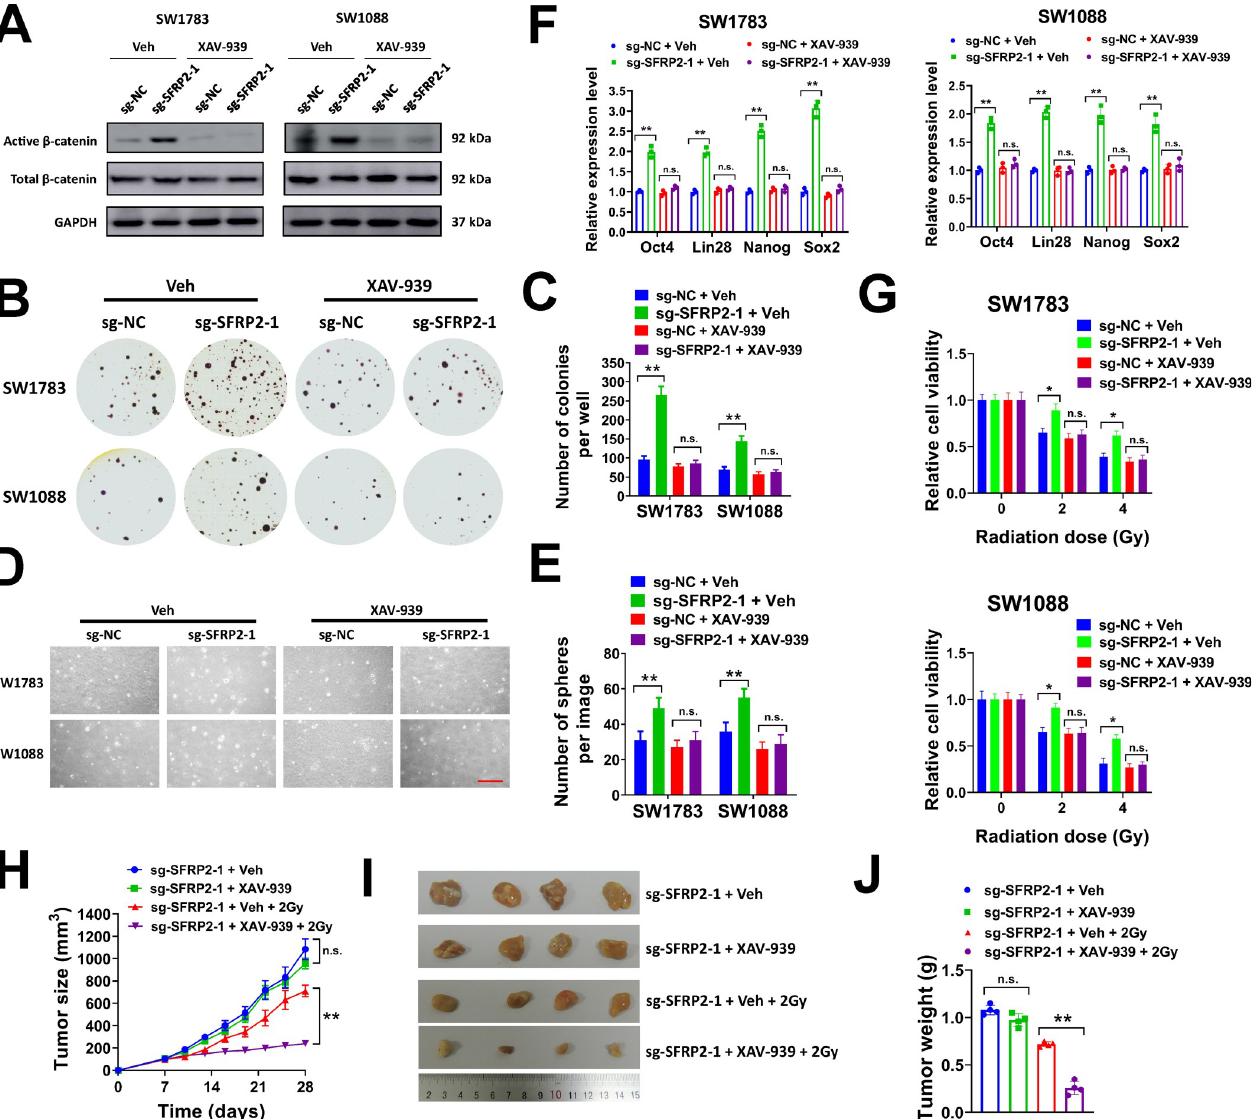
Fig 6. Pharmacological inhibition of Wnt/ β -catenin pathway represses sphere formation, stemness and radioresistance of glioma cells. A, SW1783 and SW1088 cells infected with sg-SFRP2-1 or sg-NC lentiviral particles were seeded in 6-well plates (1 × 10 6 /well), and treated with 1 μ M XAV-939 or equal volume of DMSO (Veh) for 24 h. The protein expression of indicated genes was evaluated by western blot. B-C, SW1783 and SW1088 cells were introduced with sg-SFRP2-1 or sg-NC lentiviral particles, then seeded in 6-well plates at 8000/well for soft agar assay. Cells were treated with 1 μ M XAV-939 or equal volume of DMSO (Veh) at the same time. Representative plates (B) and average number of colonies per well (C) were shown. D-E, SW1783 and SW1088 cells were introduced with sg-SFRP2-1 or sg-NC lentiviral particles, then seeded in 6-well plates at 3000/well for sphere formation assay. Cells were treated with 1 μ M XAV-939 or equal volume of DMSO (Veh) at the same time. Representative images (D) and average number of spheres per image (E) were shown. F, SW1783 and SW1088 cells introduced with sg-SFRP2-1 or sg-NC lentiviral particles were treated with 1 μ M XAV-939 or equal volume of DMSO (Veh) for 6 d, then the expression of Oct4, Lin28, Nanog and Sox2 was evaluated by qRT-PCR. G, SW1783 and SW1088 cells introduced with sg-SFRP2-1 or sg-NC lentiviral particles were seeded in 96-well plates (3000/well) and treated with 2 or 4 Gy X-ray irradiation, 1 μ M XAV-939 or equal volume of DMSO (Veh) as indicated. Cell viability was tested at 72 h after the irradiation. H-J, SW1783 cells (2 × 10 6 ) infected with sg-SFRP2-1 or sg-NC lentiviral particles were subcutaneously injected into nude mice. Tumor xenografts were treated with 2 Gy X-ray irradiation, 25 mg/kg XAV-939 or equal volume of 50% PEG-400 as indicated daily for three weeks from day 7. Tumor growth curves (H), image of tumor xenografts (I) and tumor weight (J) were shown. � P < 0.05, �� P < 0.001. n.s., not significant.